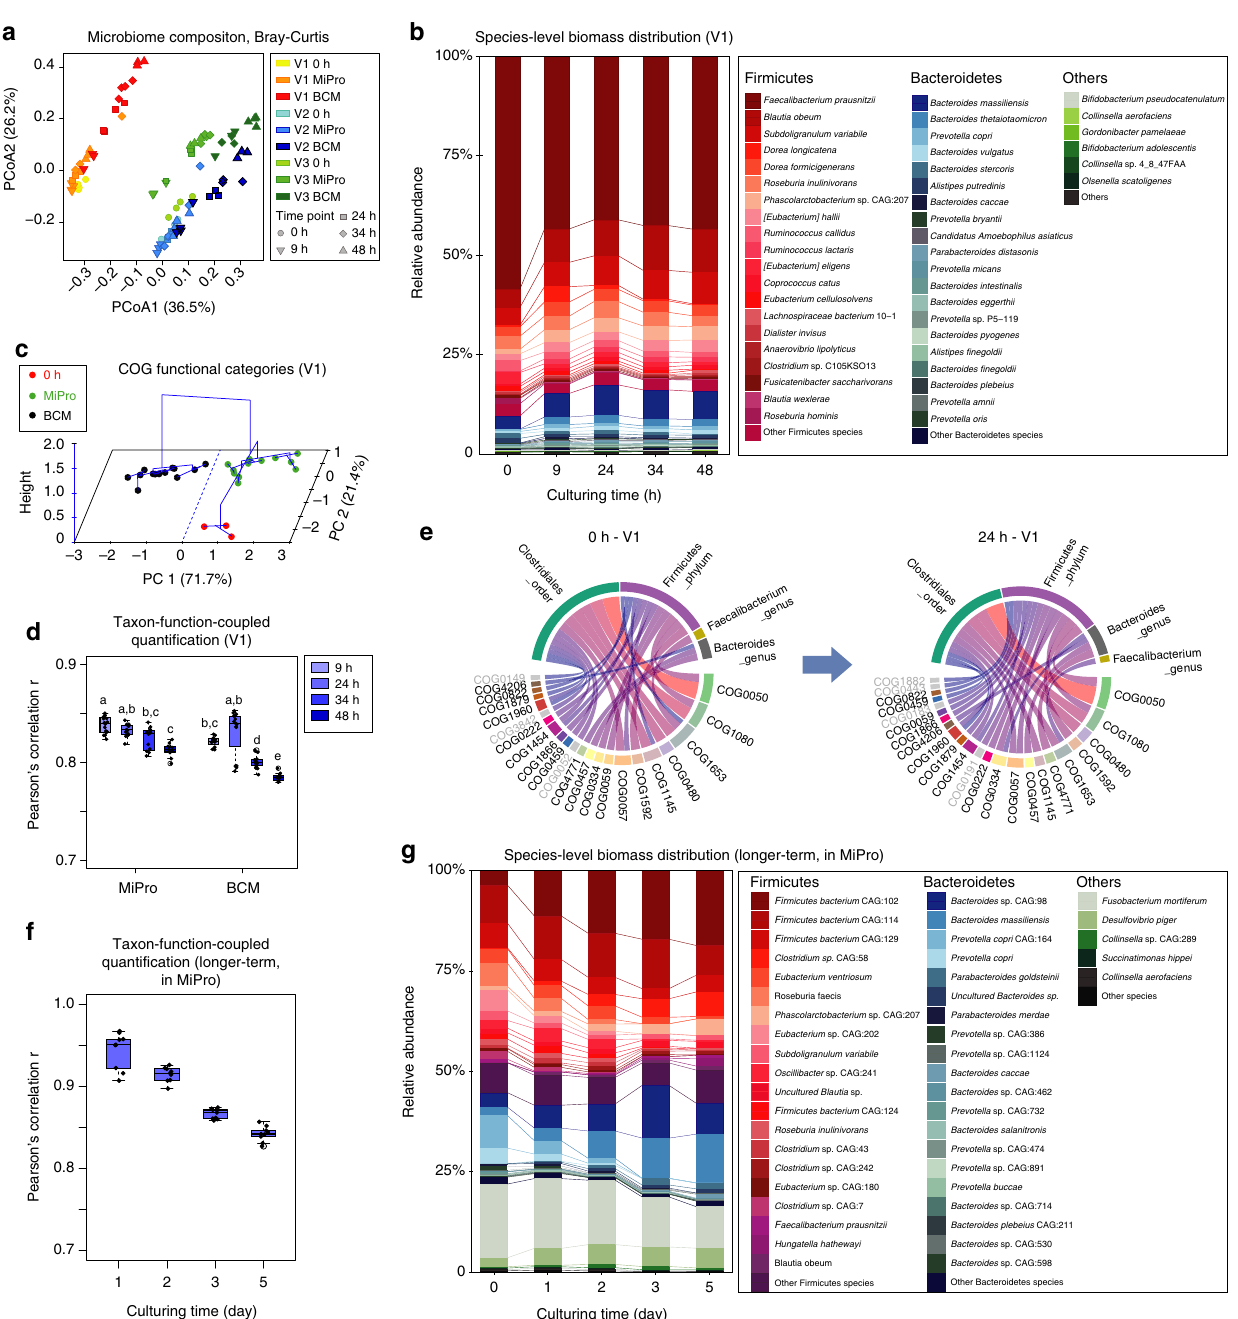
Fig. 2 Metaproteomics revealed taxonomic & functional composition stability over time. a Principal coordinate analysis (PCoA) plot with Bray-Curtis dissimilarity on species level. b Compositional bar chart showing species-level biomass distribution over time in the cultured microbiome of V1 (see Supplementary Fig. 5 for V2 and V3). c PCA scores plot with hierarchical clustering based on COG functional categories of individual V1 (see Supplementary Fig. 9 for individuals V2 and V3). d Pearson ’ s correlation coef fi cient r of taxon-speci fi c functional pro fi les between microbiome cultured over time and the baseline inoculum sample of V1 (see Supplementary Fig. 10 for V2 and V3; different letters indicate signi fi cant differences at the p = 0.05 level, Tukey-b test; box spans interquartile range (25th to 75th percentile), and line within box denotes median. Whiskers represent min to max values). For 0 h, Mipro 9 h, BCM 24 h and 34 h, n = 4 technical replicates; for Mipro 24 h, 34 h and 48 h, BCM 9 h, and 48 h, n = 4 technical replicates. e Visualization of associated taxa-functions enrichment analysis between 24 h MiPro-cultured and 0 h baseline samples in V1 (top 30 correlations were shown). Width of blocks and linkages represents number of matched proteins. Gray letters indicate un-paired pathways within the top 30 connections. f Pearson ’ s correlation coef fi cient r of taxon-speci fi c functional pro fi les between the baseline inoculum and microbiome cultured in MiPro over a 5-day period. n = 3 technical replicates. g Compositional bar chart showing species-level biomass distribution of a gut microbiome cultured in MiPro over a 5-day period. Underlying data are provided in the Source Data fi le